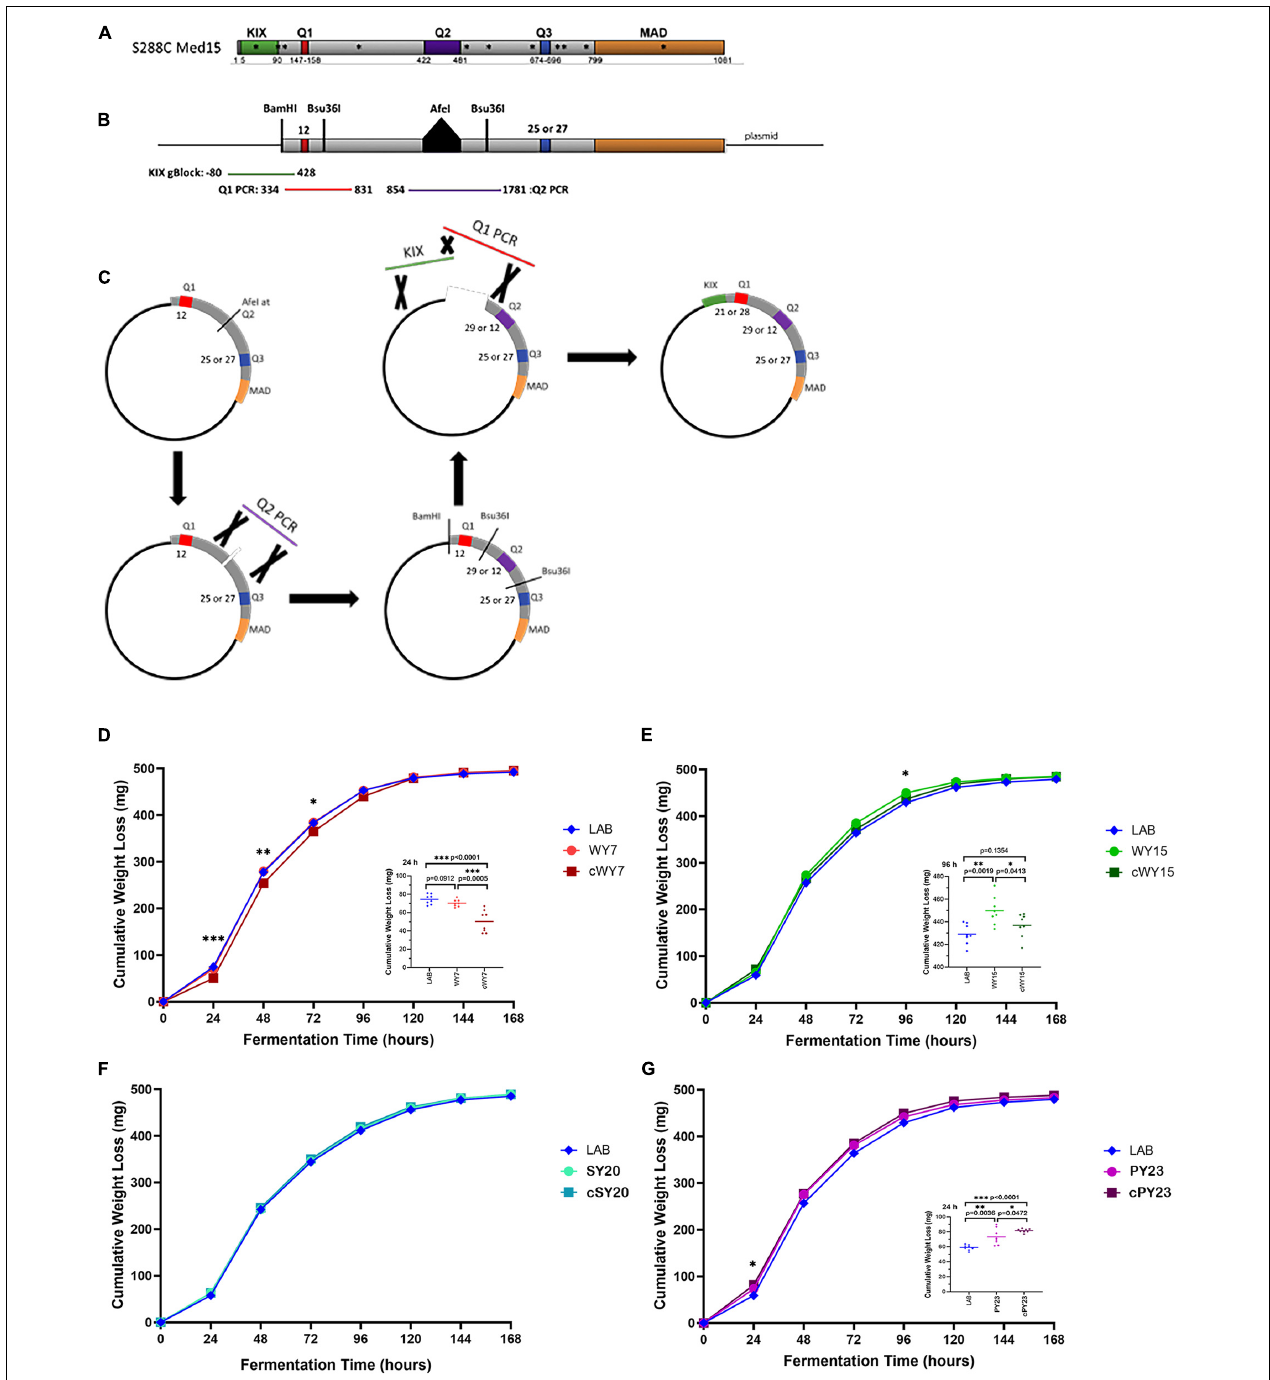
FIGURE 8 | Both glutamine tracts and non-glutamine SNPs are involved in the fermentation booster phenotypes seen in strains carrying WY MED15 . (A) The S288C (LAB) Med15 protein is shown in cartoon form with the positions of the three glutamine tracts between the N terminal KIX domain and the C terminal MAD domain indicated. Also shown with asterisks are the positions of non-synonymous SNPs in the wine yeast MED15 alleles evaluated in this study. (B) A second cartoon of a synthetically reconstructed S288C Med15 protein that lacks the KIX domain and has an Afe I site at the normal position of the Q2 tract and have either 25 or 27 glutamines at Q3. PCR fragments are shown to indicate the region amplified from the MED15 -WY alleles that were designed to encompass the Q tract without nearby SNPs. (C) The process by which “clean” WY alleles were constructed from the parts illustrated in panel (B) . (D–G) The fermentation profiles of the LAB allele, the original alcoholic beverage alleles ( e.g ., WY) and the “clean” ( e.g ., cWY) alleles are plotted. Data points are the averages of 8 biological replicates (transformants) and error bars are the standard deviation of the mean. Significance was assessed using a two-tailed t -test. Insets depict the distribution of data points for the most significant time